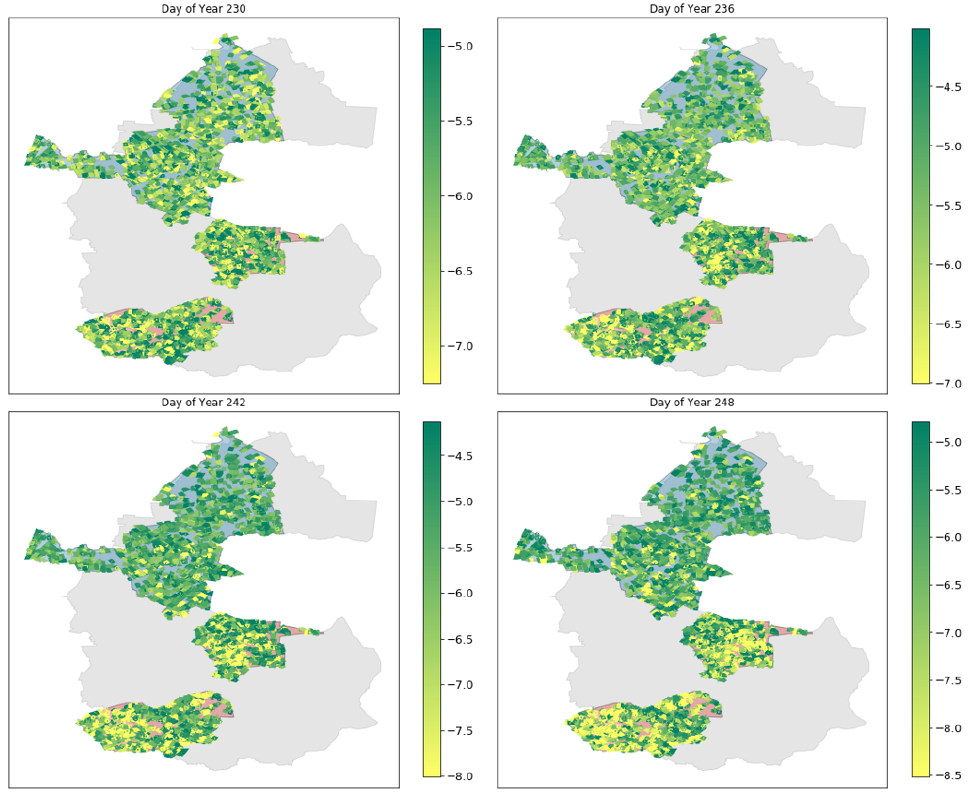
Figure 9. CR values (dB) of maize parcels in the Coevorden, Hardenberg, Tubbergen and Hof van Twente municipalities for the year